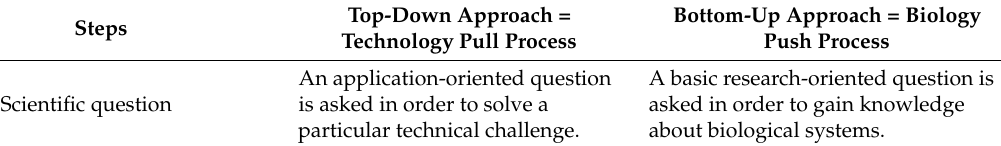
Table 4. Biomimetic approaches: individual steps [42,43].